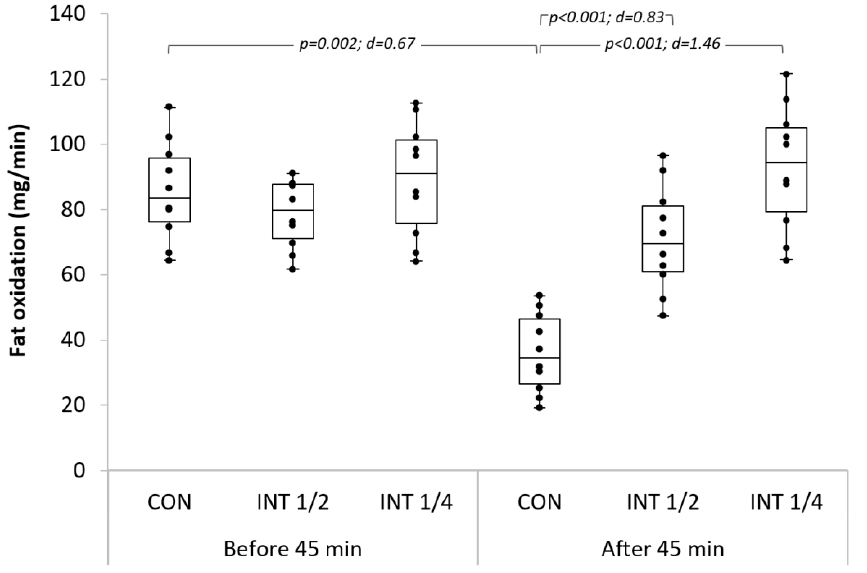
Figure 1. Fat oxidation rates of the three exercise types before and after 45 min; d: Cohen’s